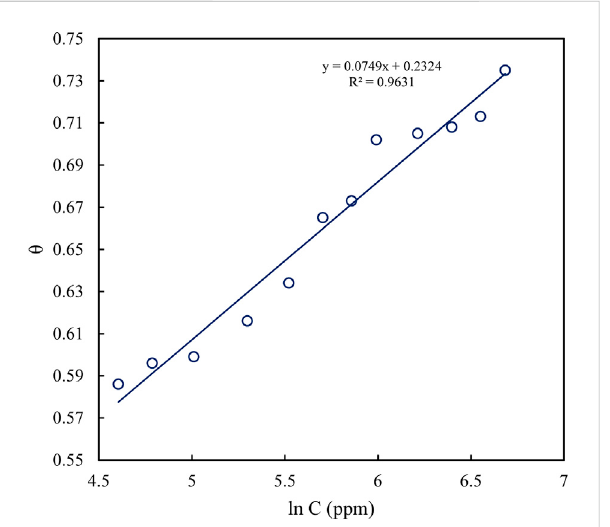
FIGURE 4 Temkin adsorption isotherm model fi tted for polyacrylamide- okra graft at 25 ° C.